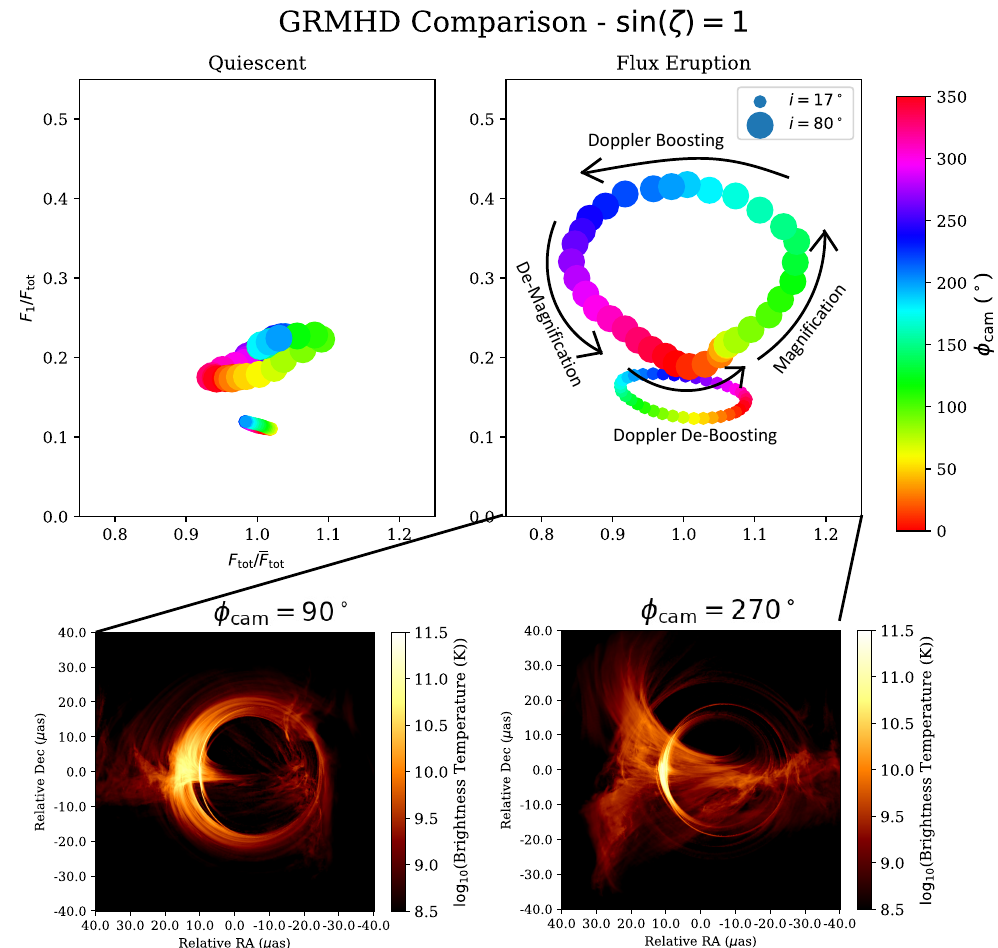
Figure 3. GRMHD PFR’s after removing magnetic field directional dependence. Snapshots (bottom) are for θ cam = 80 ◦ . Here, “quiescent” and “flux eruption” refer to time slices t = 8858 M and t = 9553 M respectively. During the flux eruption, the shape of the high-inclination ( θ cam = 80 ◦ ) PFR curve closely resembles that of the toy model, driven by the effects of Doppler boosting and magnification. Furthermore, the direct and indirect images of the flux eruption can each be seen in the snapshots